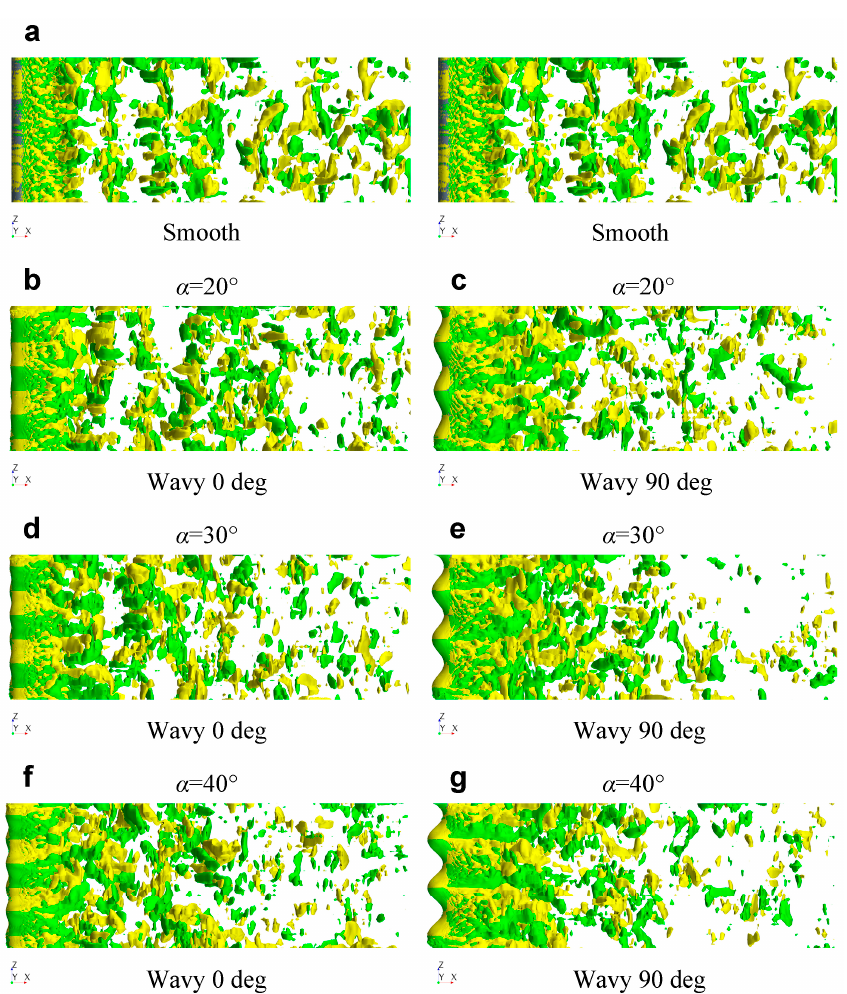
Figure 15. Comparison of the crosswise vorticity isosurfaces ( ω y = ± 15) of the smooth cylinder and three wavy cylinders. Here, ( a ) smooth cylinder; ( b ) α = 20° and θ = 0°; ( c ) α = 20° and θ = 90°; ( d ) α = 30° and θ = 0°; ( e ) α = 30° and θ = 90°; ( f ) α = 40° and θ = 0°; ( g ) α = 40° and θ = 90°.